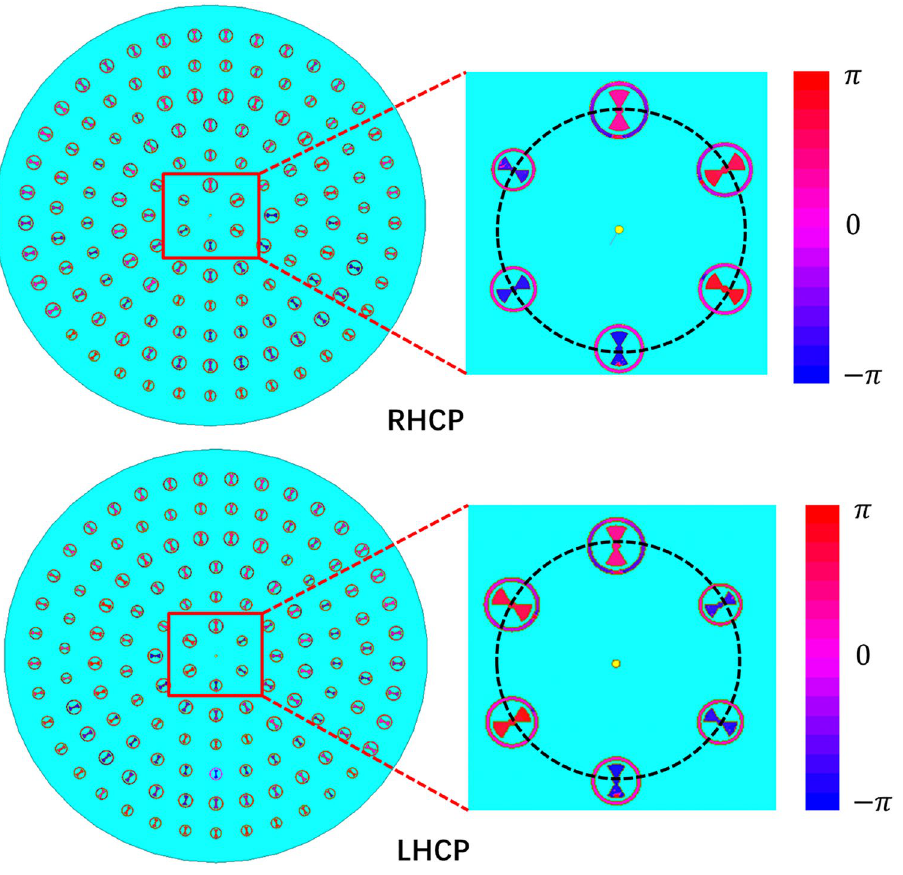
Figure 4. Phases of surface currents of the ( a ) LHCP and ( b ) RHCP MAs.